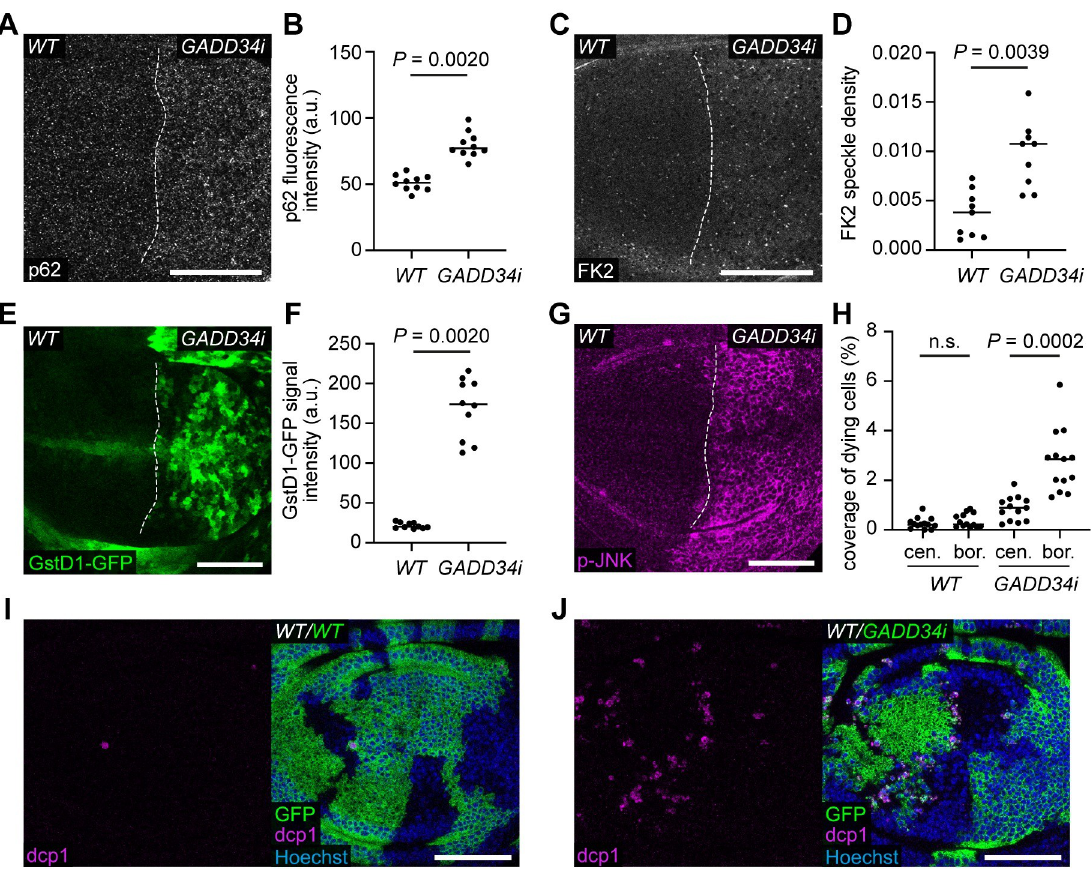
Fig 4. GADD34 knockdown induces proteotoxic stress and the loser status. ( A-B ) A wing disc carrying the GstD1-GFP reporter and expressing GADD34-RNAi ( GADD34i ) in the posterior compartment, immuno-stained for p62 (grey) ( A ) with quantification of p62 fluorescence intensity ( B ) (n = 10; two-sided Wilcoxon signed-rank test). ( C-D ) A wing disc of the same genotype as in ( A ), immuno- stained for FK2 (grey) to label mono- and poly-ubiquitinated proteins ( C ) with quantification of FK2 speckle density ( D ) (n = 9; two-sided Wilcoxon signed-rank test). ( E-F ) GstD1-GFP (green) in a wing disc of the same genotype as in ( A ), with quantification of GstD1-GFP signal intensity ( F ) (n = 10; two-sided Wilcoxon signed-rank test). ( G ) A wing disc of the same genotype as in ( A ), immuno-stained for p- JNK (magenta). ( H-J ) Wing discs harboring either GFP-positive WT cells ( I ) or GFP-positive GADD34-RNAi expressing cells ( J ) immuno-stained for dcp1 (magenta), with quantification of density of dying cells at the center (cen.) and border (bor.) of the GFP patches as indicated ( H ) (n = 13 and 13, respectively; two-sided Wilcoxon signed-rank test). The border defines cells within two cell diameters of the perimeter.